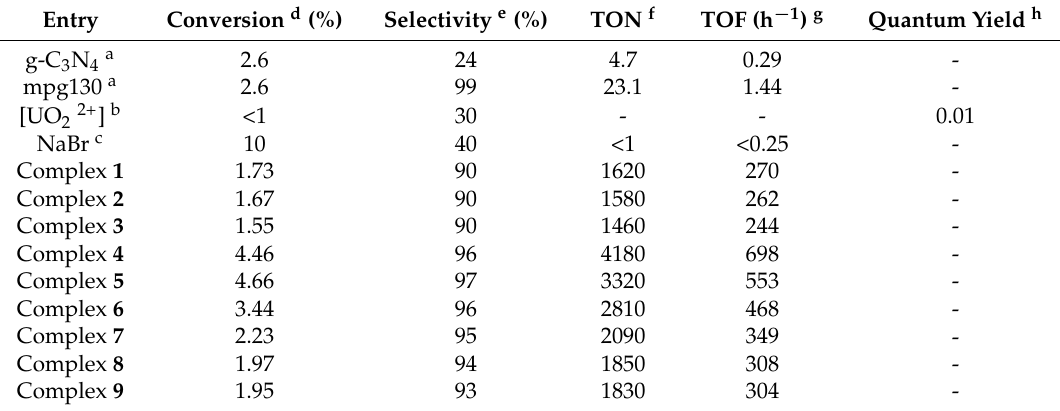
Table 3. Reaction Conditions of Catalytic Oxidation for